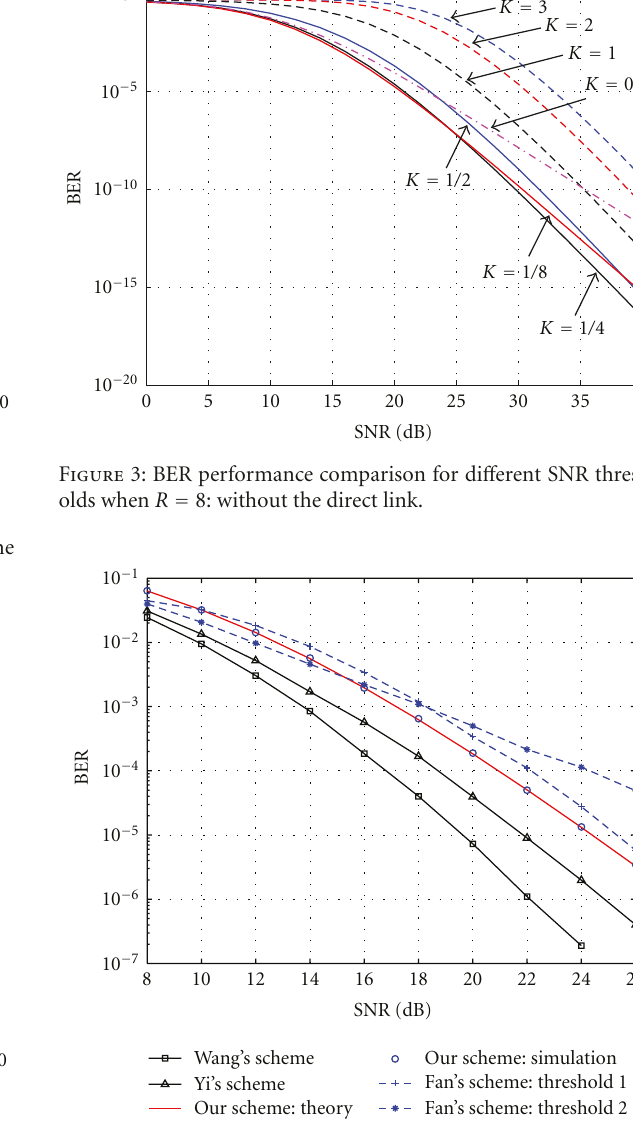
Figure 4: BER performance comparison between the HDD scheme and several MRC schemes when R =